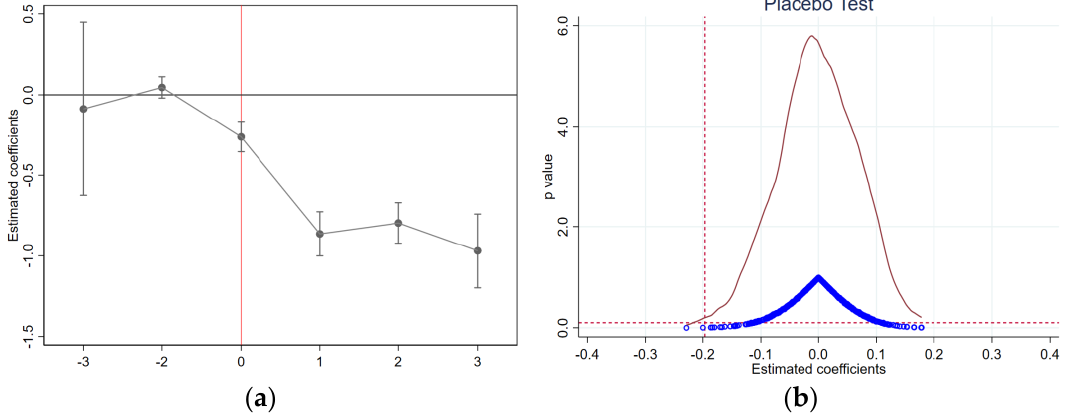
Figure 2. Parallel trend test ( a ) and placebo test ( b ). Note: In the parallel trend test ( a ), the horizontal axis indicates the period before and after EID policy implementation, 0 represents the current period, 1 represents one year after implementation, and − 2 represents two years before policy implementation. In multi-period DIDs, to avoid collinearity, period − 1 should be excluded, in which the solid point represents the value of the coefficient, and the extension line represents the confidence interval of 95%. In the placebo test ( b ), the blue circles represent the coefficient calculation results of 500 groups of virtual policy variables, and the red curve represents the distribution of coefficients. The red horizontal dotted line illustrates the significance level of 10%, and the value of coefficients in benchmark regression is illustrated by the red vertical line.